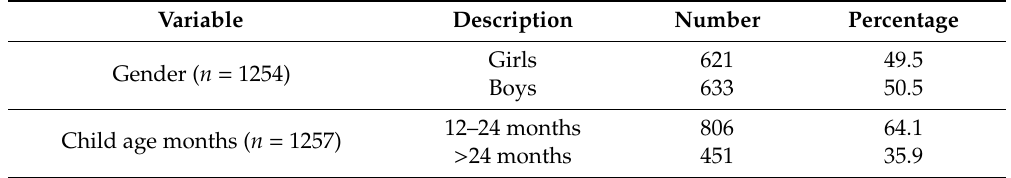
Table 2. Characteristics of mothers of children under five years of age in health